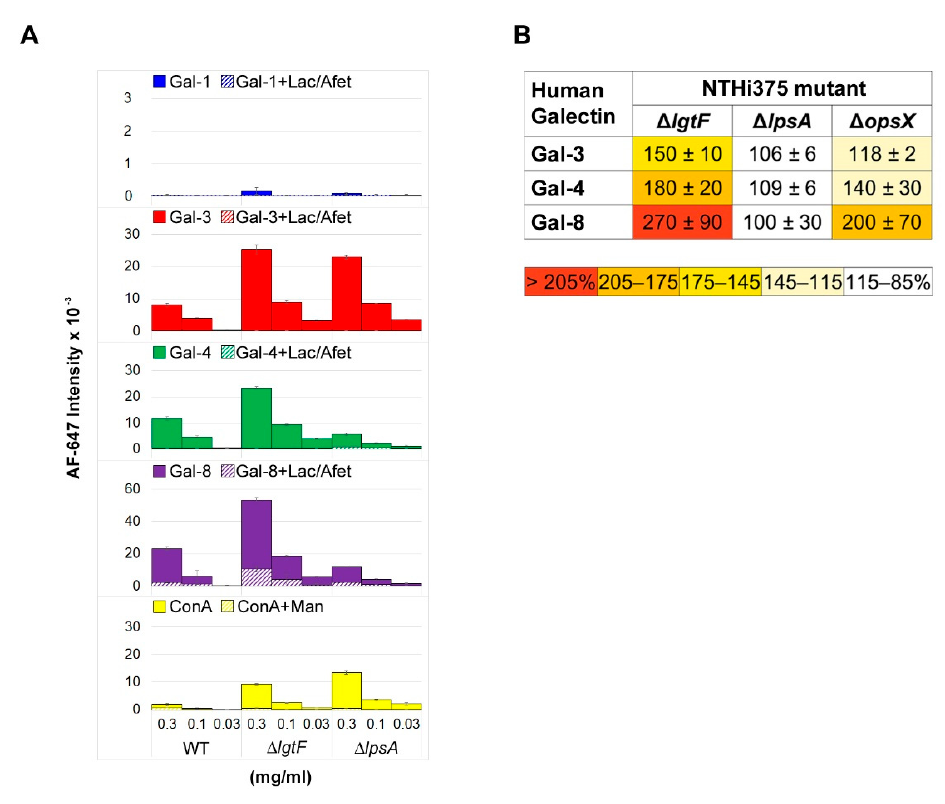
Figure 5. Microarray analysis of galectin binding to NTHi LOSs and mutant cells. ( A ) NTHi wild type, ∆ lgtF , and ∆ lpsA LOSs were printed as triplicates at three different concentrations (0.3, 0.1, and 0.03 mg/mL), and the binding of galectins was assayed in the absence (solid columns) or presence (dashed columns) of 75 mM lactose plus 1 mg/mL asialofetuin in solution, as described in Materials and Methods. Binding of biotin-labelled concanavalin A (ConA) at 20 µ g/mL in the absence or presence of 0.1 M mannose, also detected by incubation with 1 µ g/mL AF647-streptavidin, is also shown. ( B ) Relative binding strength of galectins to NTHi mutant cells. The binding of galectins to array-printed wild type and mutant NTHi cells was assessed simultaneously, and the relative binding strength was calculated as percentage taking for each galectin binding to wild type NTHi as 100%. Data shown correspond to mean values calculated from binding intensities to triplicate samples of bacteria printed at OD 600 of 0.3, 0.6, and 1. Standard deviations of the mean are given.